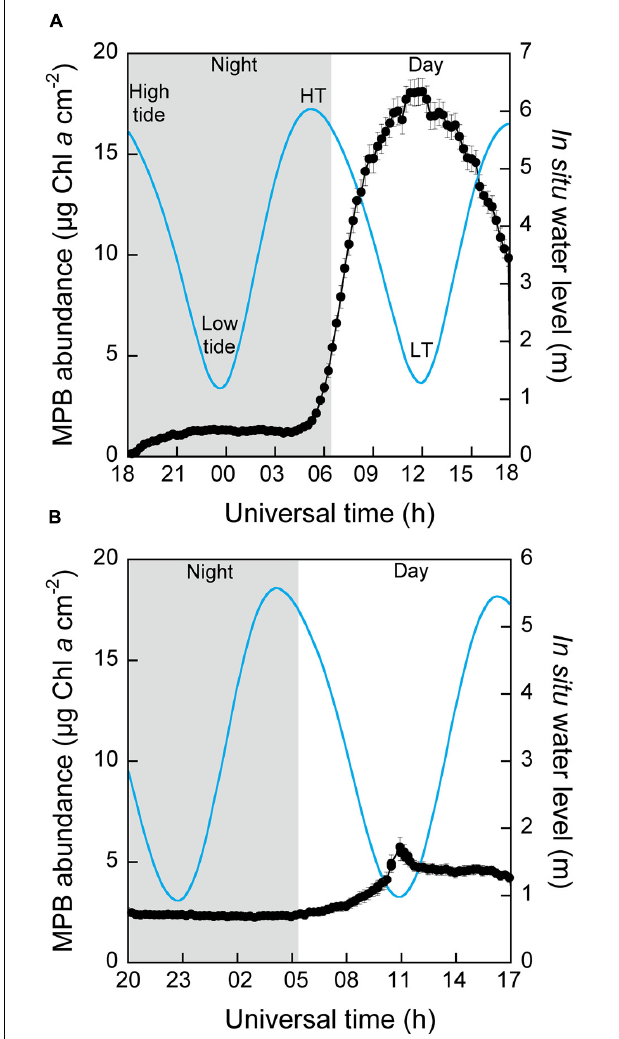
FIGURE 2 | Microphytobenthos (MPB) abundance ( µ g Chl a cm − 2 ) at the surface of sediment and in situ water level (m) at the site of sampling as a function of universal time (h UT) measured continuously for 24 h under control light conditions (i.e., 24-h natural photoperiod) for (A) muddy sediment mostly inhabited by epipelic diatoms and (B) sandy-muddy sediment mostly inhabited by epipsammic diatoms. Black line: MPB abundance ( µ g Chl a cm − 2 ); blue line: water level (m) at the site of sampling; gray and white backgrounds: the natural night and day periods, respectively. Microphytobenthos abundance was derived from Chl a fluorescence ( F t level) as measured with an Imaging-PAM and HPLC analysis of Chl a sediment content ( Supplementary Figure S2 ); values are the mean ± SD of 5 Imaging-PAM “areas of interest” on the sediment tray. Water-level data were retrieved from the Service Hydrographique et Océanographique de la Marine (SHOM, France) database. See Section “Materials and Methods” for further details, and Supplementary Figure S5 for MPB abundance patterns when the low tide timing was close to sunset and/or sunrise (i.e., spring and neap